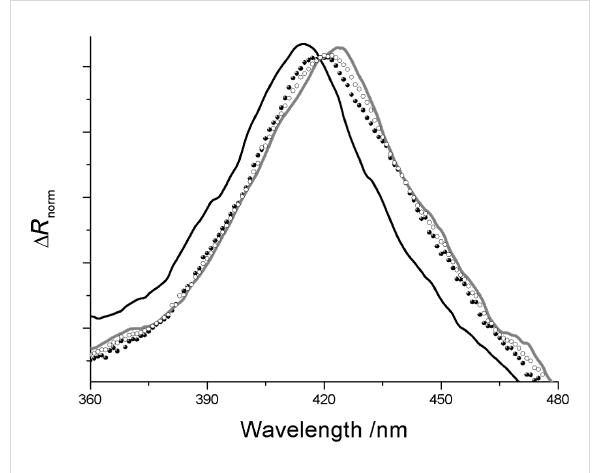
Figure 5: Normalized reflection spectra of the Cu,H 2 -Por 2 floating films spread on a subphase containing N -methylphenethylamine (filled black circles), α -methylbenzylamine (unfilled circles) and aniline (grey solid line) (10 − 5 M) compared with the reflection spectrum of the bis-por- phyrin derivative, floating film recorded on ultrapure water (black solid line). All the spectra were recorded at a surface pressure of 12 mN/m and appropriately multiplied or divided in order to have the same maximum value of Δ R of the Cu, H 2 -Por 2 floating layer on the ultra- pure water